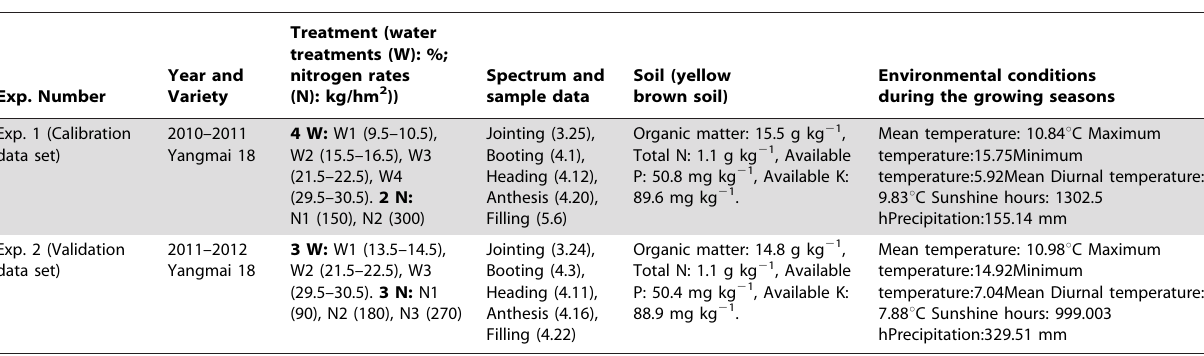
Table 1. Basic information about different field experiments.